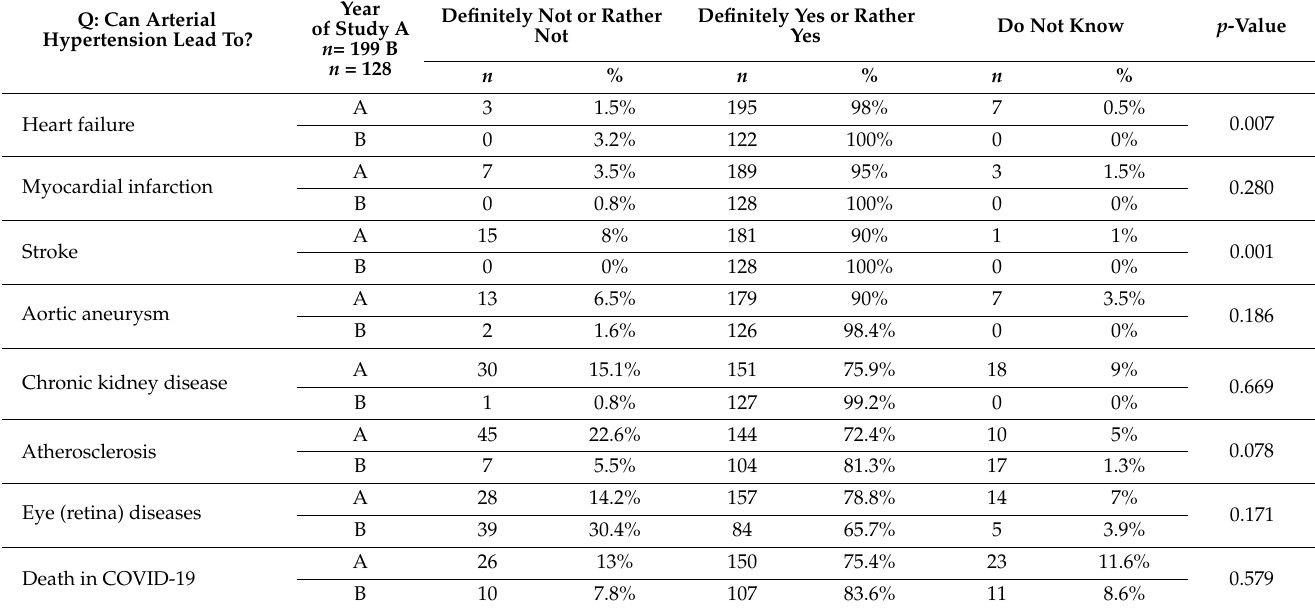
Table 4. Effect of arterial hypertension on the occurrence of diseases ( n =